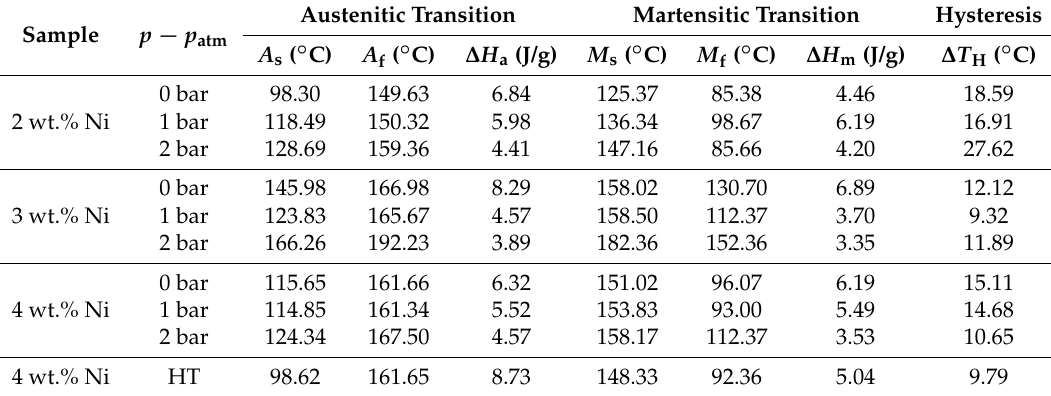
Table 3. Summary of transformation temperatures, enthalpies, and temperature hysteresis determined from the DCS analysis of all the